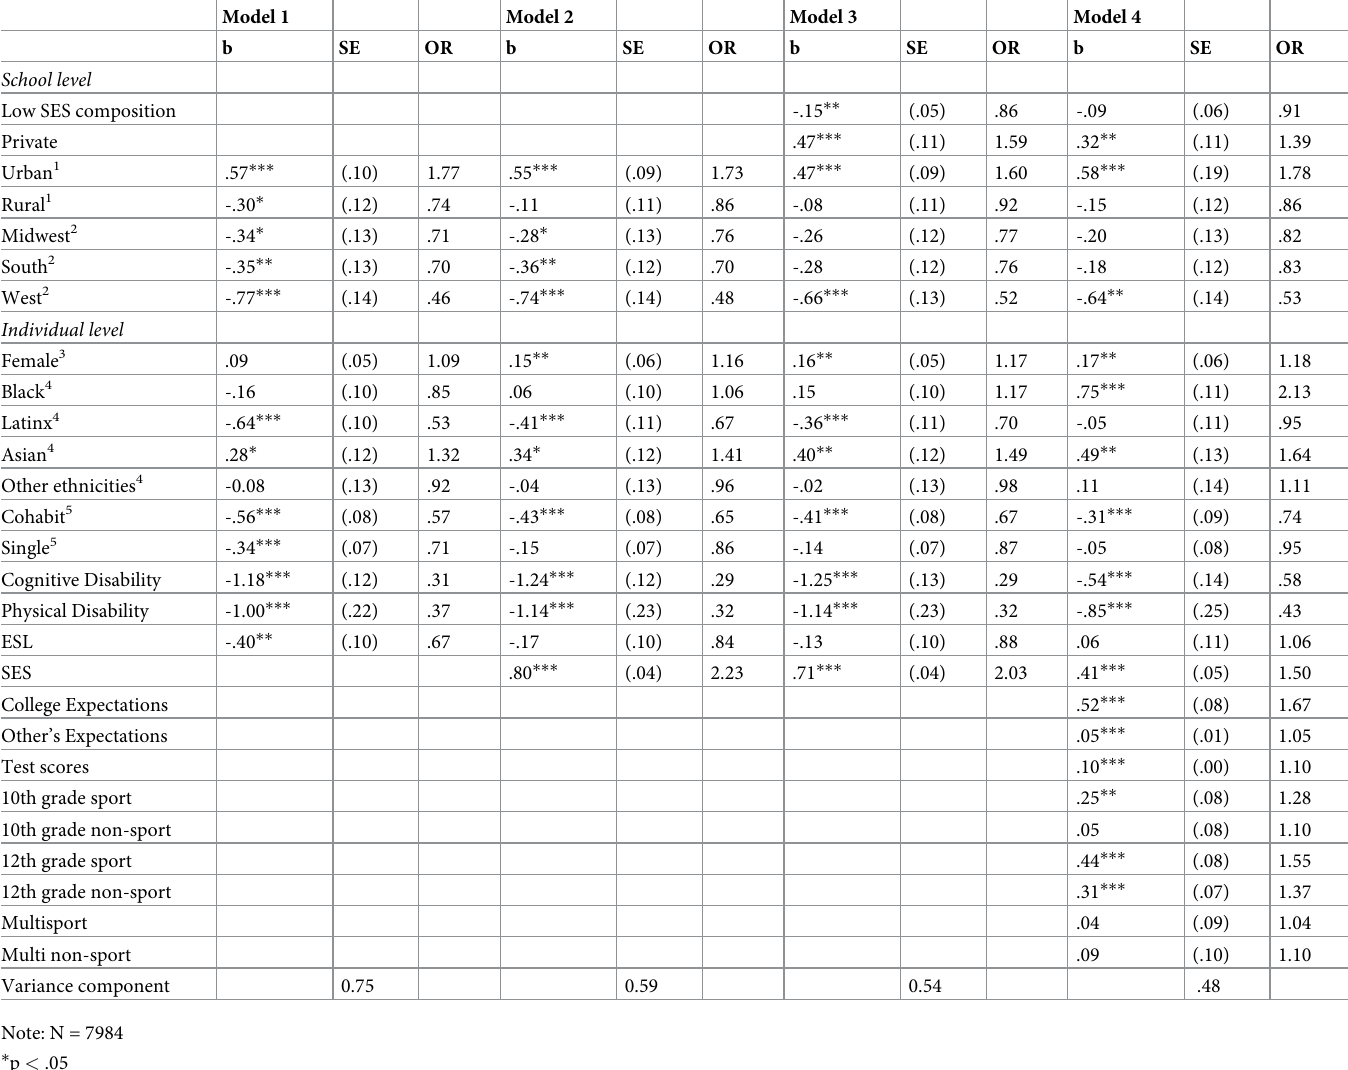
Table 2. Multilevel logistic regressions predicting the likelihood of attending a four-year versus a two-year college among college attendees. Model 1